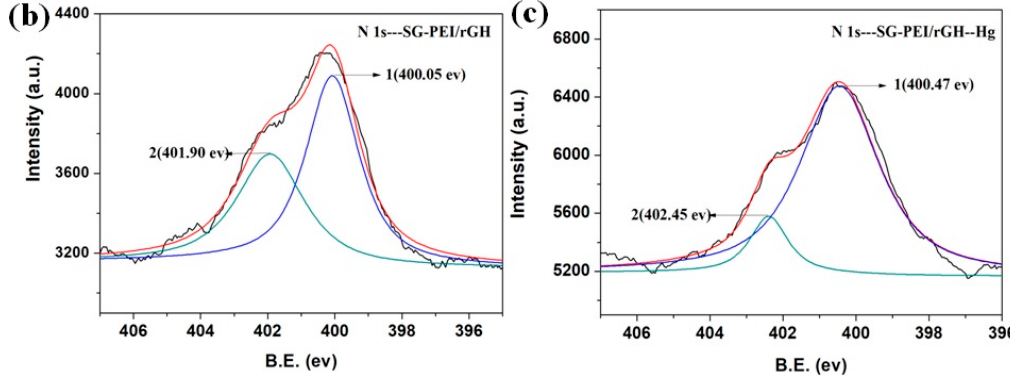
Figure 11. ( a ) XPS wide scan and ( b , c ) N1s spectrum of SG-PEI/rGH and SG-PEI/rGH-Hg.